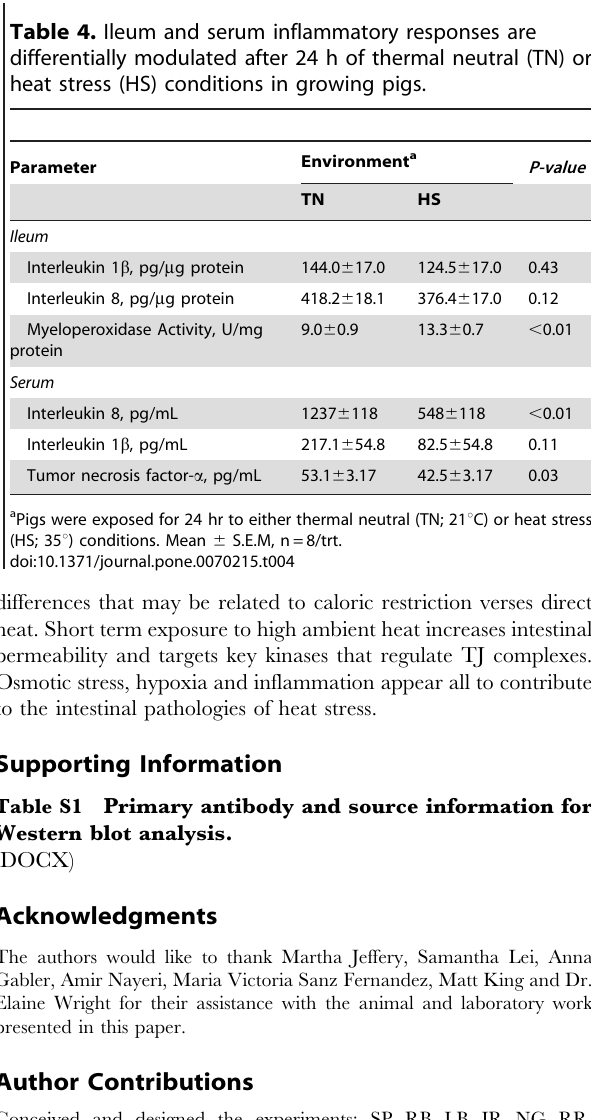
Table S1 Primary antibody and source information for Western blot analysis.